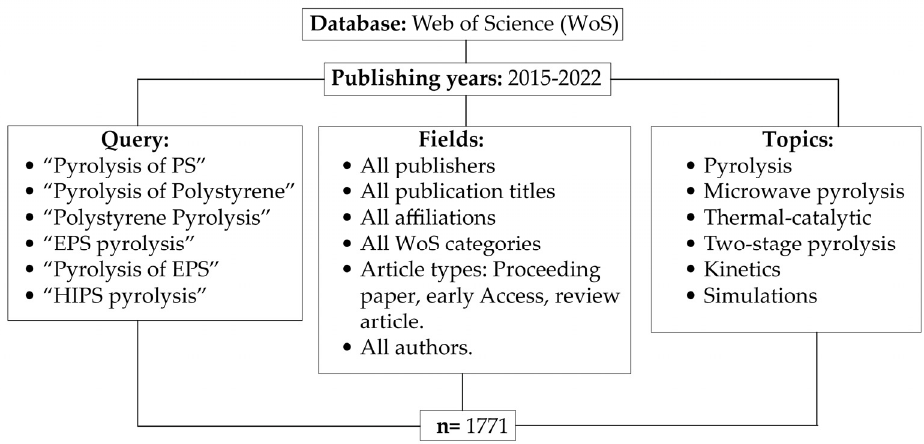
Figure 1. Criteria of bibliometric analysis of PS pyrolysis.